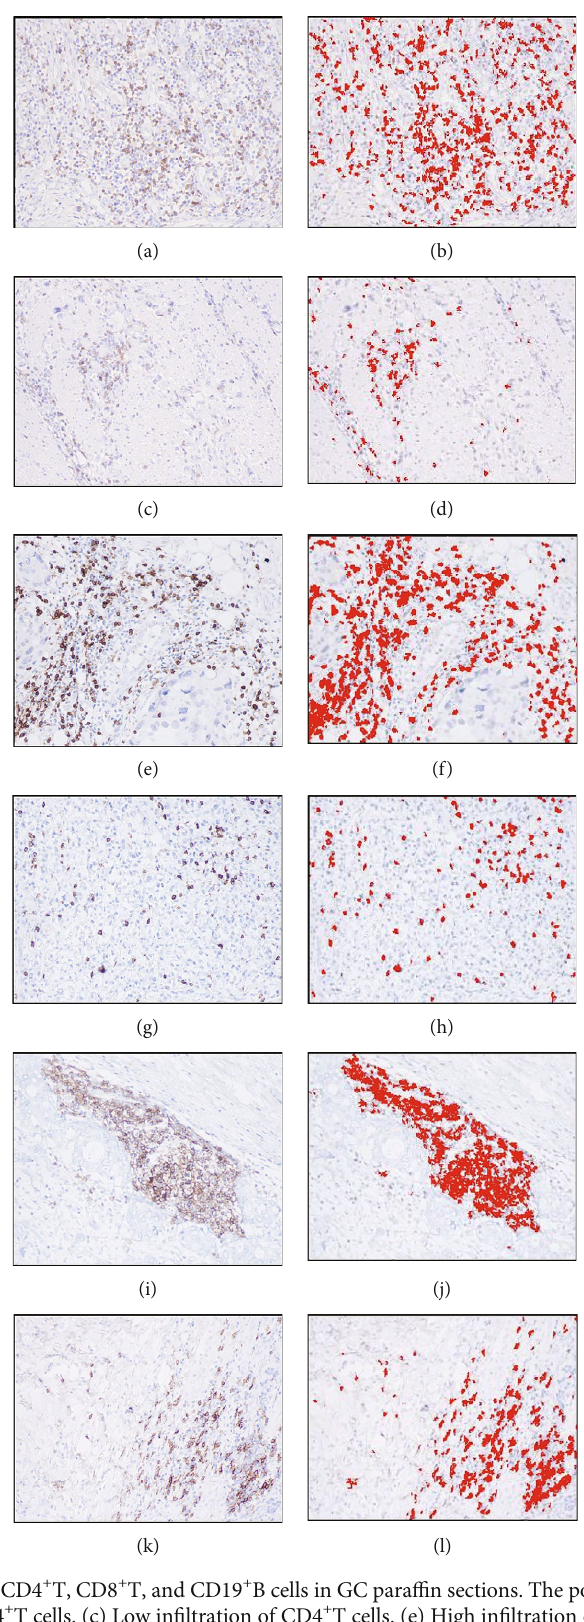
Figure 2: Immunohistochemistry of CD4 + T, CD8 + T, and CD19 + B cells in GC para ffi n sections. The positive part was marked red by Image- Pro Plus. (a) High in fi ltration of CD4 + T cells. (c) Low in fi ltration of CD4 + T cells. (e) High in fi ltration of CD8 + T cells. (g) Low in fi ltration of CD8 + T cells. (i) High in fi ltration of CD19 + B cells. (k) Low in fi ltration of CD19 + B